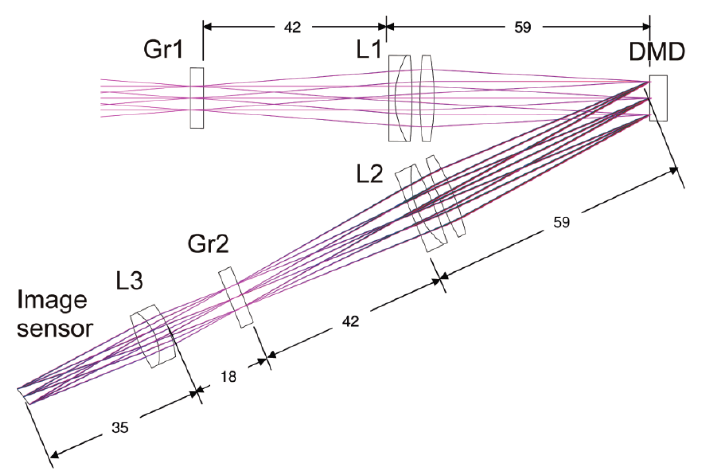
Figure 2. Optical layout of the protection setup. A DMD is located in the intermediate focal plane of a Keplerian telescope (achromatic lenses L1 and L2). Wavelength